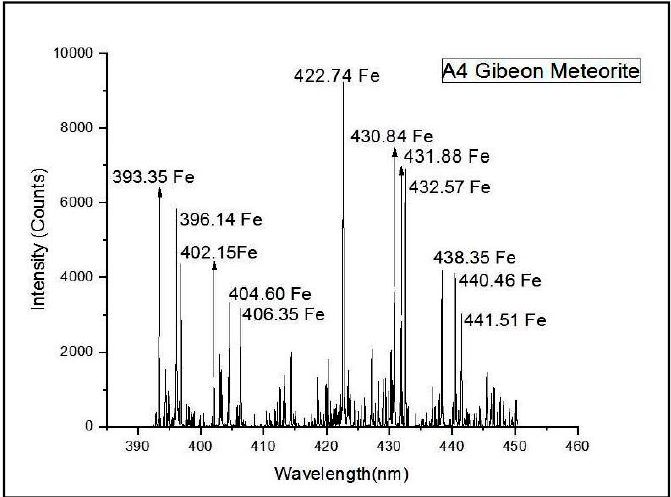
Figure 5. LIBS spectrum of Sample A4 at 390–450 nm spectral region.